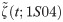
Intraday profile of the skewness during 1S04.Lef panel: The black dots represent the values of ζi(t; 1S04), the red line ζ˜(t;1S04) and the ultramarine and navy blue lines corresponds to the linear fit of the red curve for the morning and afternoon parts of the session whose slopes are 10−3 ± 10−4 and 1.5 × 10−3 ± 10−4, respectively. Right panel: The values of the slopes of the fittings as a function of the semester. The ultramarine blue dots represent the morning values ofthe slope and the navy blue triangles the absolute value of the slope in the afternoon part of the trading session.